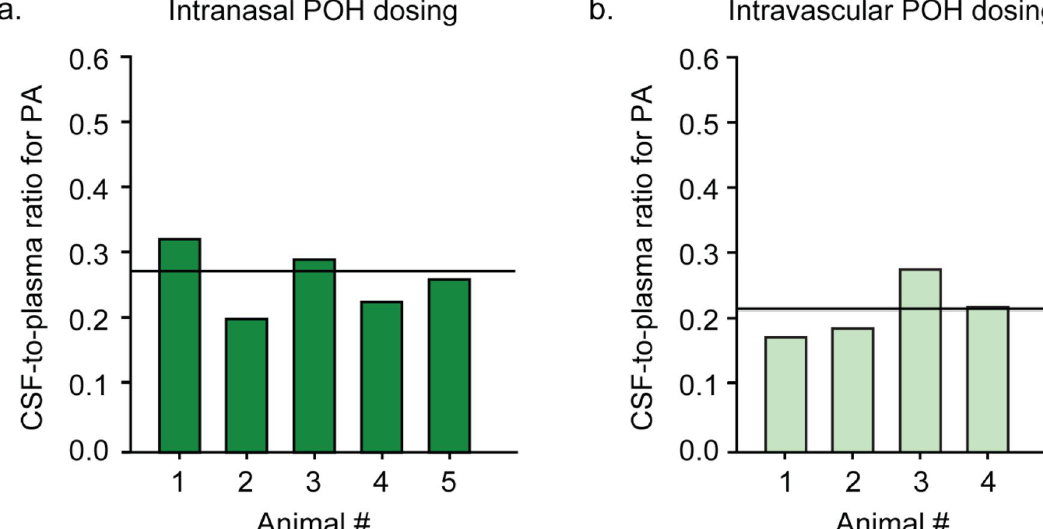
Figure 5. CSF-to-plasma ratio for PA following intranasal (a) or intravascular (b) POH administration. Values for intranasal and intravascular POH administration are shown in dark green bars (a) and light green bars (b) respectively. Solid lines indicate the mean values for each